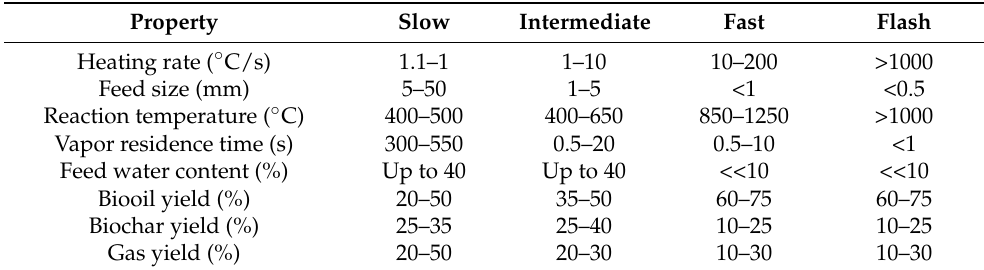
Table 37. Different pyrolysis processes and products’ yield [62].